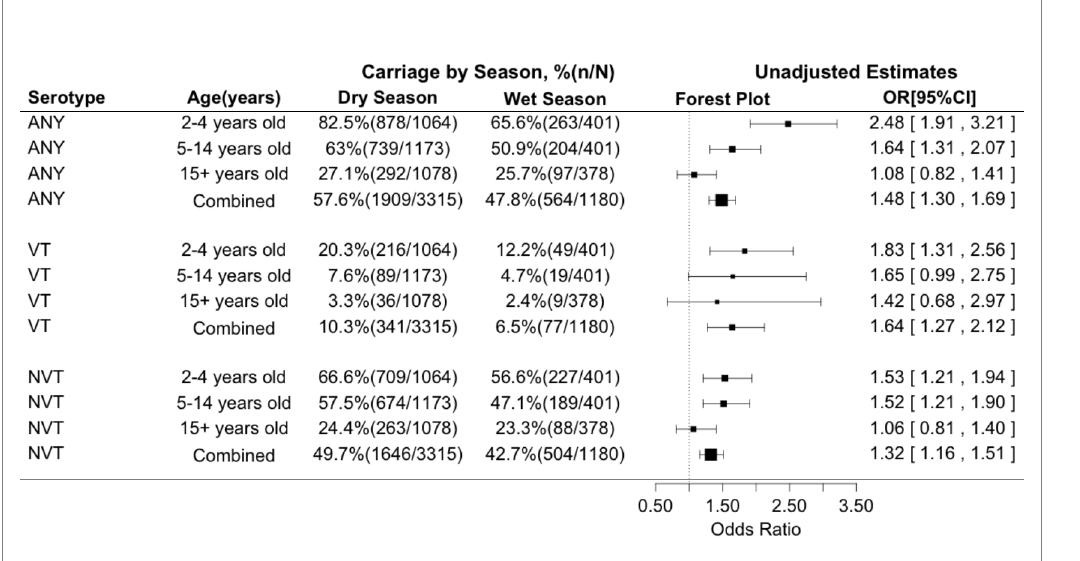
Fig 2. Prevalence of nasopharyngeal carriage in dry and rainy seasons in the study villages by age group for the different study